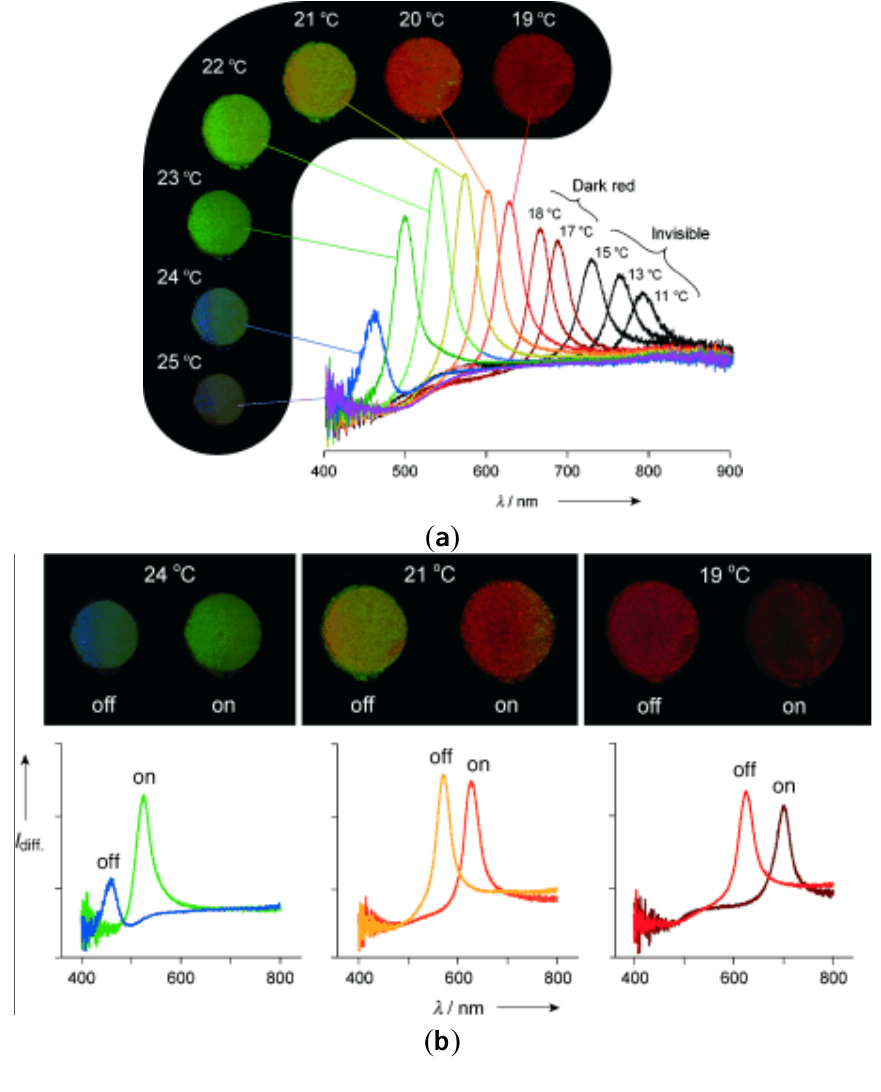
Figure 21. ( a ) Spectroscopic characterization of the porous gel. Photographs and reflection spectra of the porous poly(NIPA-co-AAB) gel in the dark at various